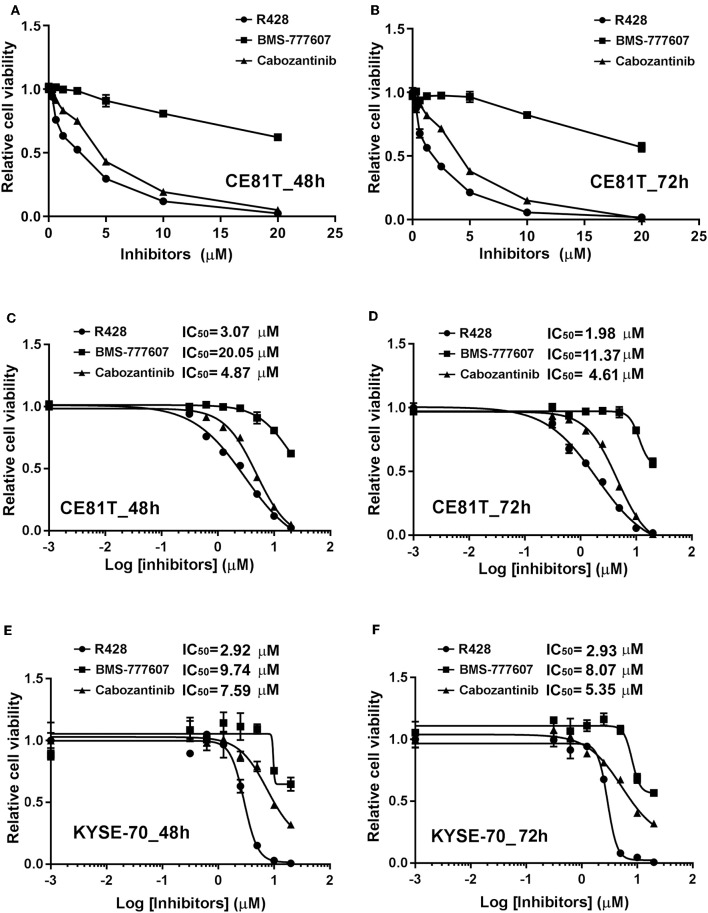
The efficacy of AXL and c-Met inhibitors in esophageal squamous cell carcinoma (ESCC) cells. Dose–response curves for cytotoxicity are displayed for CE81T cells in response to the inhibitors, including R428 (•), BMS-777607 (■), and cabozantinib (▴), at doses of 0.001, 0.3125, 0.625, 1.25, 2.5, 5, 10, and 20 μM after 48 h (A) and 72 h (B) of treatment. Sigmoidal dose-inhibition curves were constructed for CE81T (A–D) and KYSE-70 ESCC cells (E,F) in response to indicated amounts of indicated inhibitors at 48 h (C,E) and 72 h (D,F) post-treatment. The half maximal inhibitory concentration (IC50) values are exhibited as indicated.